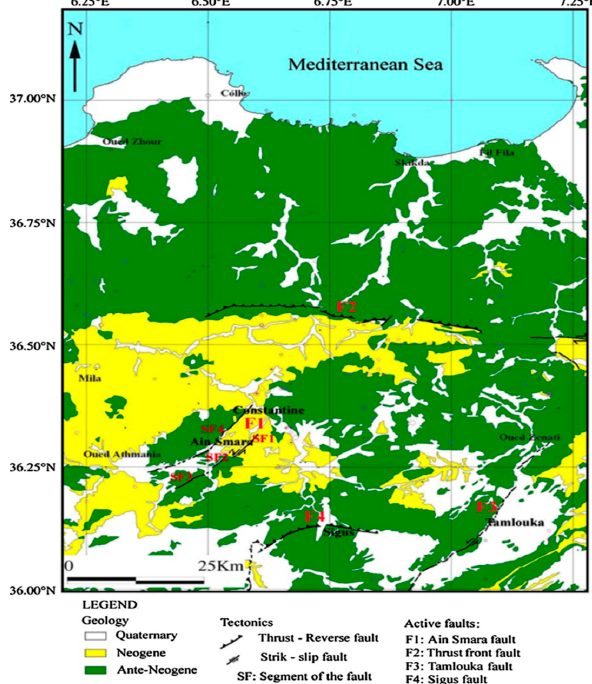
Figure 4. Map of active faults in Constantine region (Bouhadad 2009; CGS 2011a. Representation of Ain-Smara fault and Constantine city (Bounif et al. 1987)). Ain-Smara fault and Constantine city (Bounif et al.